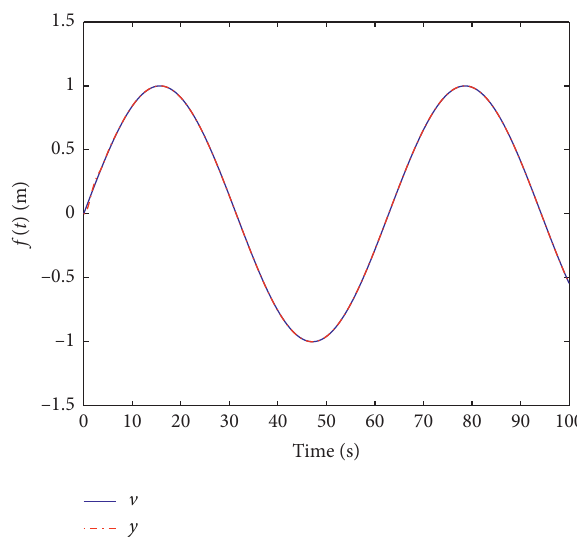
Figure 13: Control system response of sin ( 0 . 1 t )